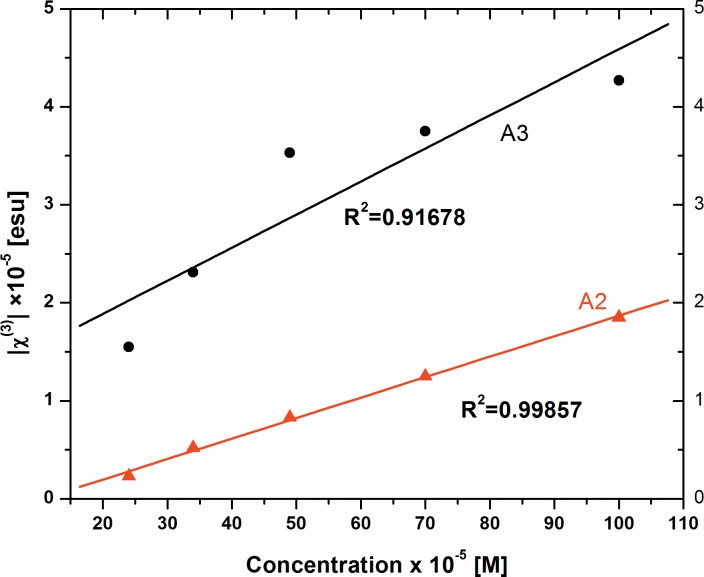
Variation of absolute third order susceptibility |χ(3)| of Dyes A2 and A3 as a function of concentration.